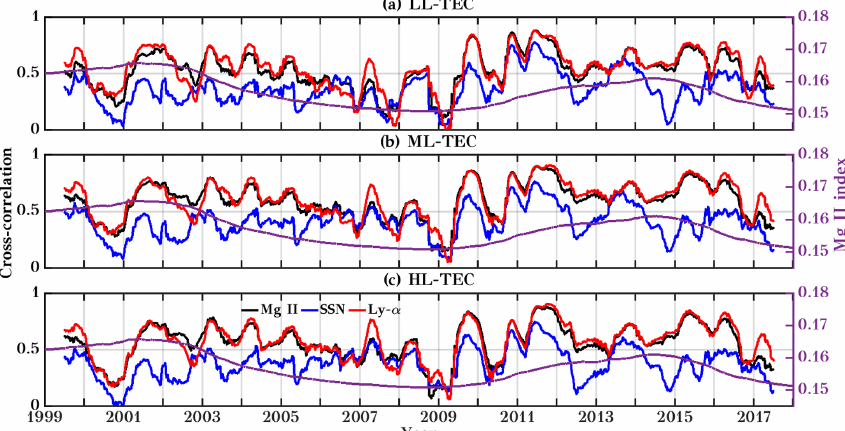
Figure A6. Running cross-correlation between the TEC and different solar proxies using a 365d running window for LL, ML, and HL. The second y axis shows the 365d running mean time series of the Mg II index. Here Mg II, SSN, and Ly- α are marked by black, blue, and red colors, respectively. Correlation coefficients between the PCs and solar and geomagnetic proxies at lag 0.